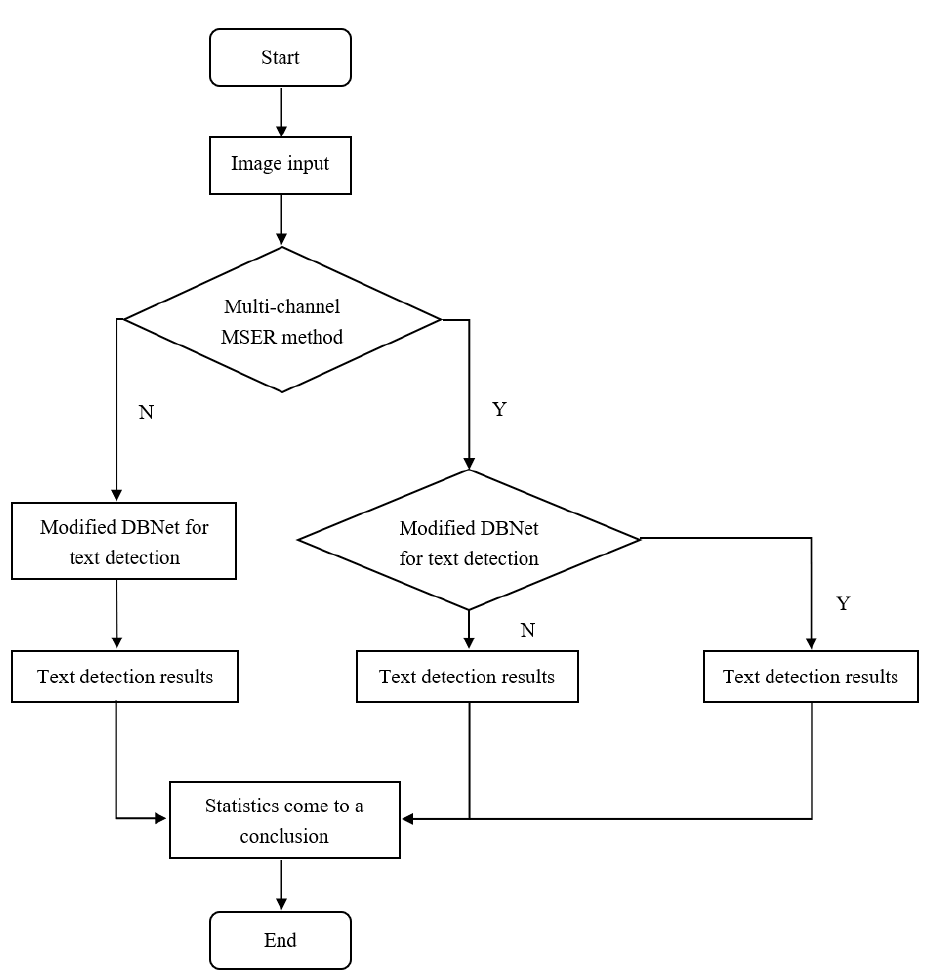
Figure 7. Flow chart of the experiment.